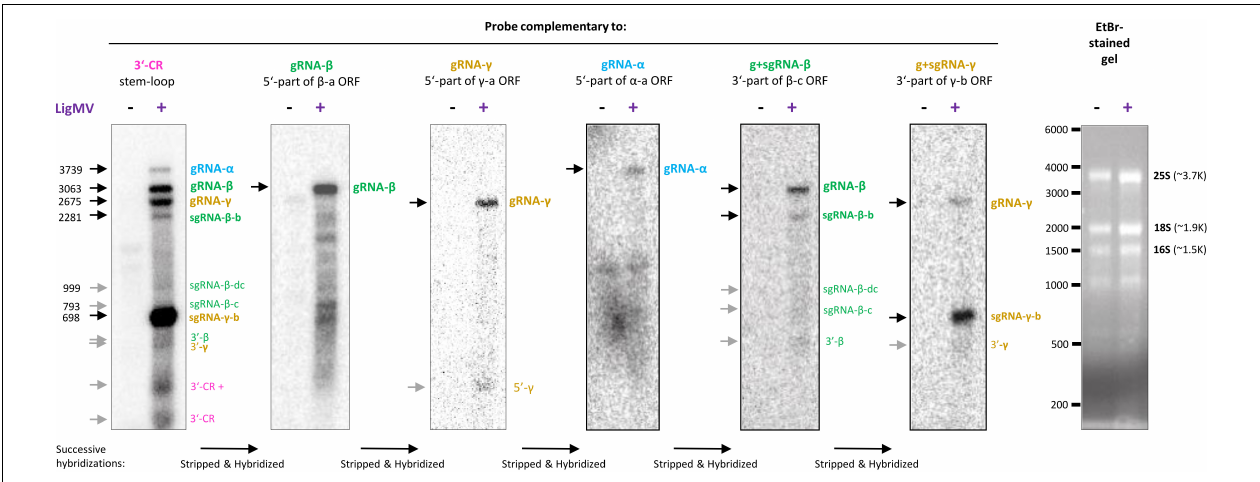
FIGURE 6 | Northern blot hybridization analysis of ligustrum mosaic virus (LigMV) genomic (g) and subgenomic (sg) RNAs. Total RNA from healthy (–) and LigMV-infected (+) Ligustrum vulgare leave samples (HYT-23 and HYT-24, respectively) was separated on 1.2% agarose denaturing gel. The gel was stained with ethidium bromide (EtBr) and then RNA was transferred and cross-linked to nylon membrane. The membrane was successively hybridized with DNA oligonucleotide probes complementary to the 3 (cid:48) -common (CR) stem-loop sequence, 5 (cid:48) -part of the β -a open reading frame (ORF), 5 (cid:48) -part of the γ -a ORF, 5 (cid:48) -part of the α -a ORF, 3 (cid:48) -part of the β -c ORF, and 3 (cid:48) -part of the γ -b ORF (the probe sequences are given in Supplementary Table 1 , and their positions on the virus genome are indicated in Figure 3 ). Cropped images of the membrane scans after each hybridization and the EtBr-stained gel are shown (see uncropped images and their alignment in Supplementary Figure 4 ). The positions of the g and sg RNAs identified with high confidence are indicated with black arrows, those identified with lower confidence with gray arrows and their expected sizes in nucleotides are given on the left. The positions of RNA size markers indicated (see the RNA ladder itself in the uncropped image in Supplementary Figure 4